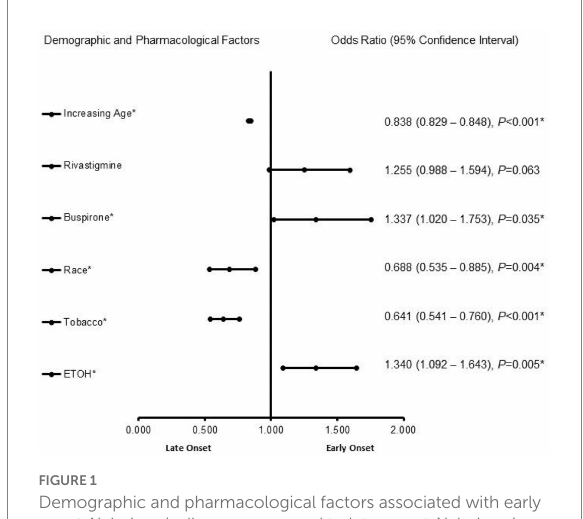
FIGURE 3 Demographic and Pharmacological risk factors associated with early-onset Alzheimer’s disease in female patients. Adjusted OR < 1 denotes factors associated with a late onset, while OR > 1 denotes factors associated with early onset. Hosmer-Lemeshow test ( p < 0.001*), Cox & Snell (R 2 = 0.132). The overall classified percentage of 93.3% was applied to check for the fitness of the logistic regression model. The asterisk (*) Indicates statistical significance ( p < 0.05) with a 95% confidence interval.